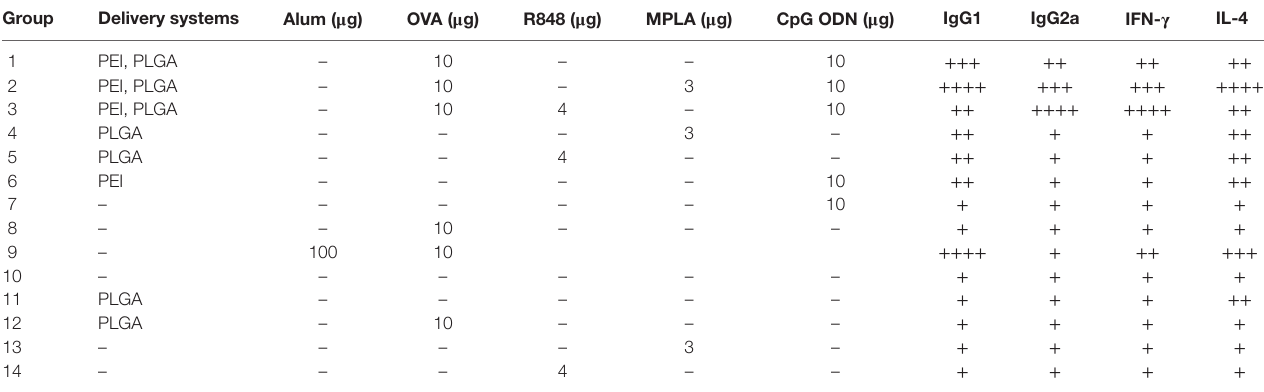
The level of IgG isotypes or cytokine levels in descending order is indicated by ++++ , +++ , ++ , and + . Highest level illustrated by ++++ and lowest level + . Alum, aluminum hydroxide; CpG ODN, cytosine–phosphorothioate–guanine oligodeoxynucleotide; MPLA, monophosphoryl lipid A; OVA, ovalbumin; PEI, polyethylenimine; PLGA, poly(lactic-co-glycolic)